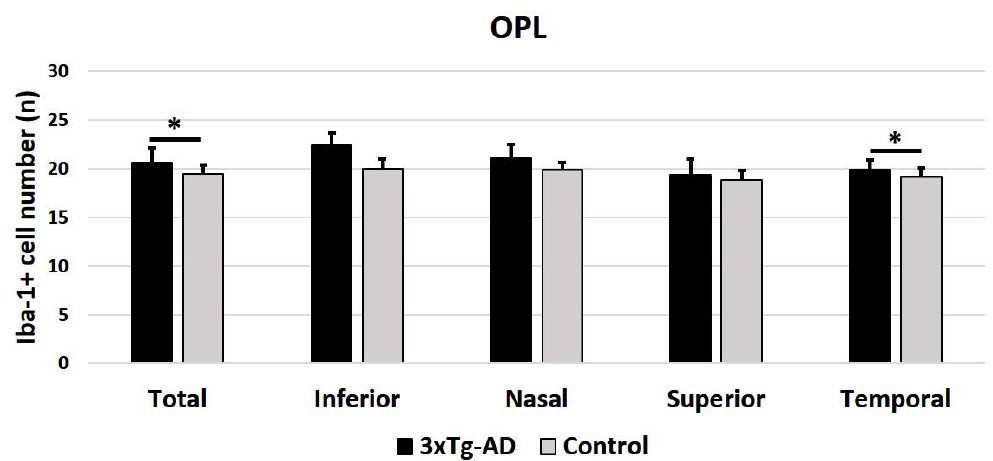
Figure 4. Number of Iba-1 + cells in the outer plexiform layer (OPL) in the 3xTg-AD and in age-matched control mice in the different retinal zones (inferior, nasal, superior, and temporal), as well as in the total retina. A total of 192 images were analyzed for each study group (3xTg-AD and control). Histograms show the mean number (± standard deviation, SD) of the Iba-1 + cells per area of 0.1502 mm 2 . Statistically significance indicators: * p < 0.05.